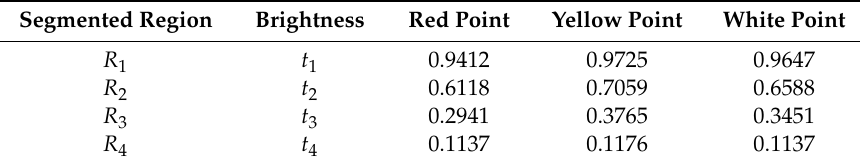
Figure 8. The marking point image segmentation by K-means clustering: ( a ) Segmented image for the red marking point, ( b ) Segmented image for the yellow marking point, and ( c ) Segmented image for the white marking point. Table 1. The brightness of four regions after the marking point is segmented.